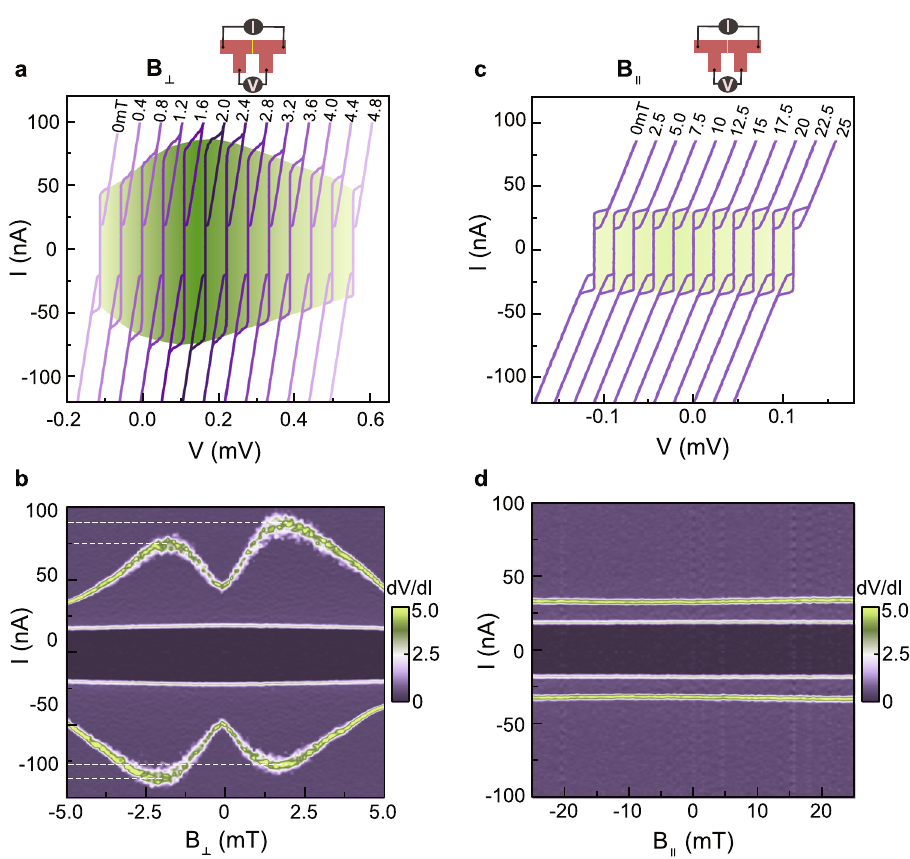
Fig. 2 Evolution of critical current with the magnetic fi eld. a Selected current I vs voltage V traces of the device measured at 11 V, and 20 mK as a function of the magnetic fi eld, in the range of ±5 mT, applied perpendicular to the plane of the sample. The curves are shifted horizontally for clarity. A background color highlights critical current variation with B ⊥ . b Contour plot of dV / dI as a function of the current and the out-of- plane magnetic fi eld. c Selective I – V traces measured at 11 V, and 20 mK as a function of the in-plane magnetic fi eld applied the range of ±25 mT. d Contour plot of dV / dI as a function of the current and the in-plane magnetic fi